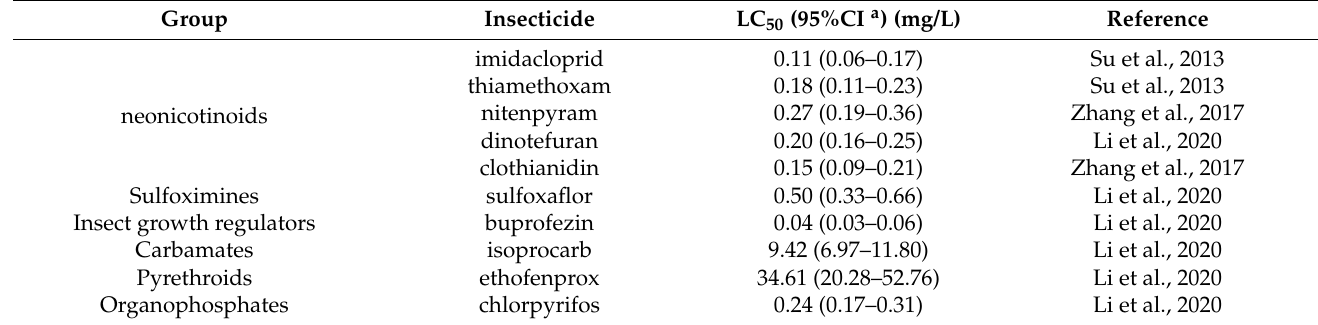
Table 2. The susceptibility baseline of S. furcifera to